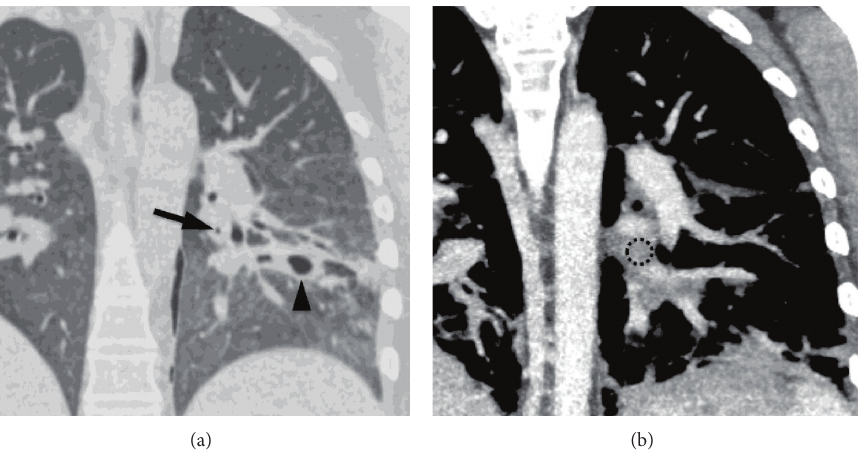
Figure 2: The lungs showing a focus of air in the pulmonary vein (arrow in (a)) and cavitary lesion (arrowhead). (b) is a CT with contrast performed earlier to show that the air is located in a pulmonary vein (dashed